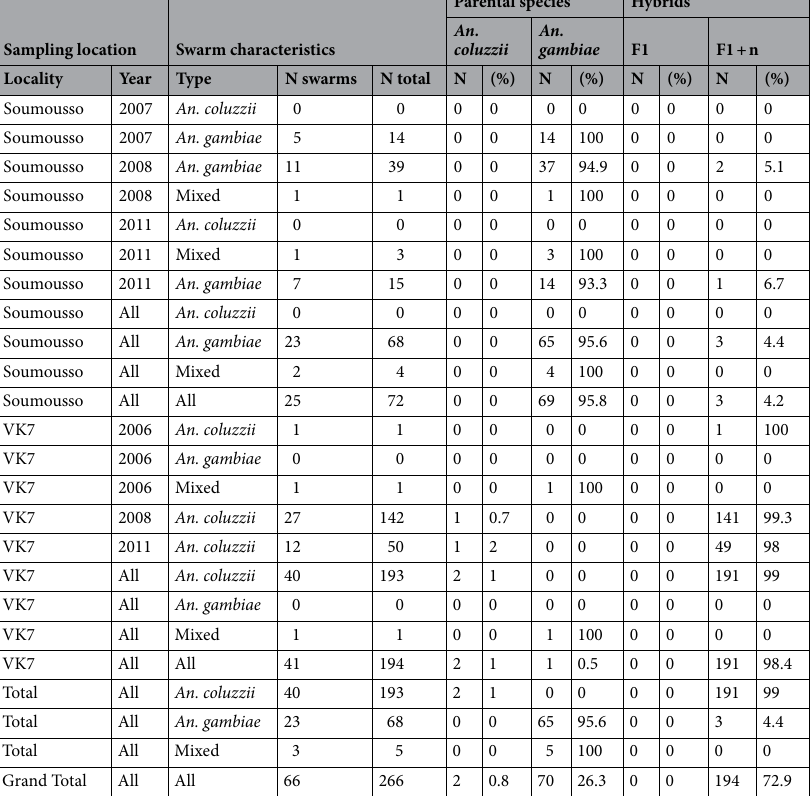
Table 2. Number and percentage of An. coluzzii and An. gambiae , and F 1 and F 1+n hybrid females from monospecific and mixed swarms. Females were collected from swarms in Soumousso (2006, 2007, 2008 and 2011) and VK7 (2006, 2008 and 2011). The swarm type (monospecific An. coluzzii and An. gambiae s.s. or mixed with males of both species), number of swarms sampled, and total number of individuals genotyped are indicated. All means the total number of swarms per type or per village sampled during the period of the